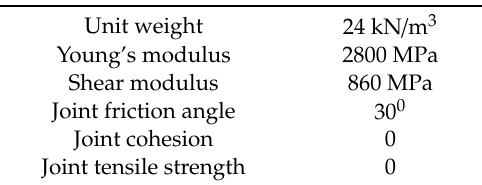
Figure 5. ( a ) Numerical model of Frontinus Gate in Hierapolis; ( b ) history locations. Table 1. Material